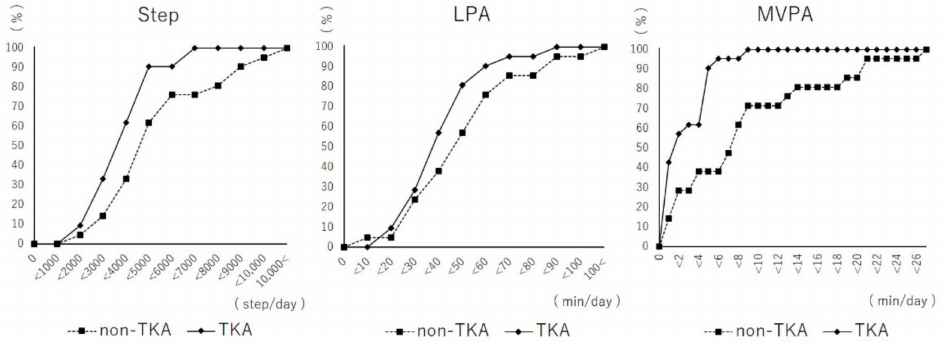
Figure 2. Differences in physical activity levels between the TKA group and the non-TKA group. Lines show an ac- cumulation plot according to the activity levels of the two groups. Abbreviations: LPA, light physical activity; MVPA, moderate-to-vigorous physical